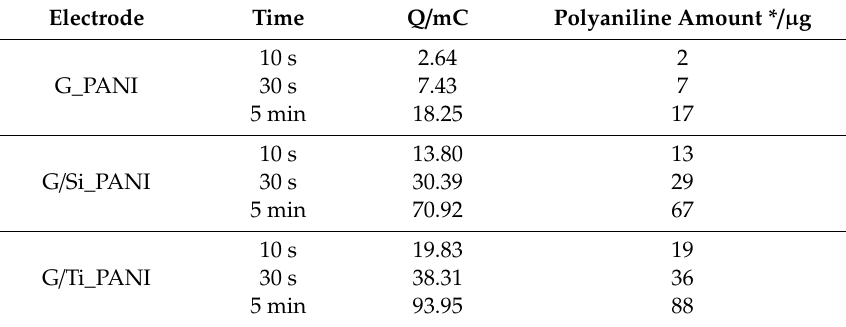
Table 1. Charge obtained from the potentiostatic pulse and the calculated amount of electrodeposited polyaniline on each